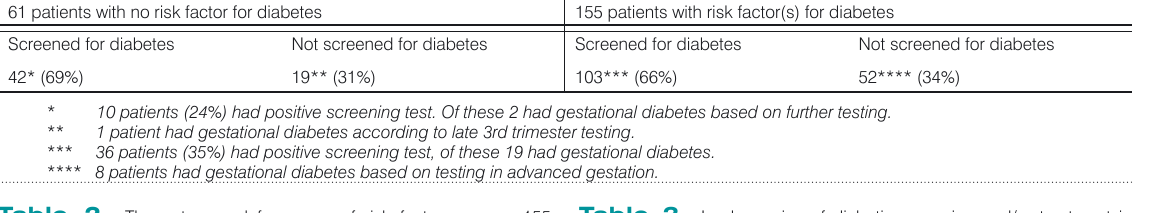
Table 2. The nature and frequency of risk factors among 155 gravidas predisposed for gestational diabetes.